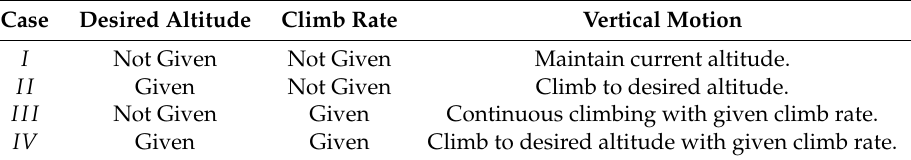
Table 3. Cases of leader’s vertical motion with desired altitude and climb